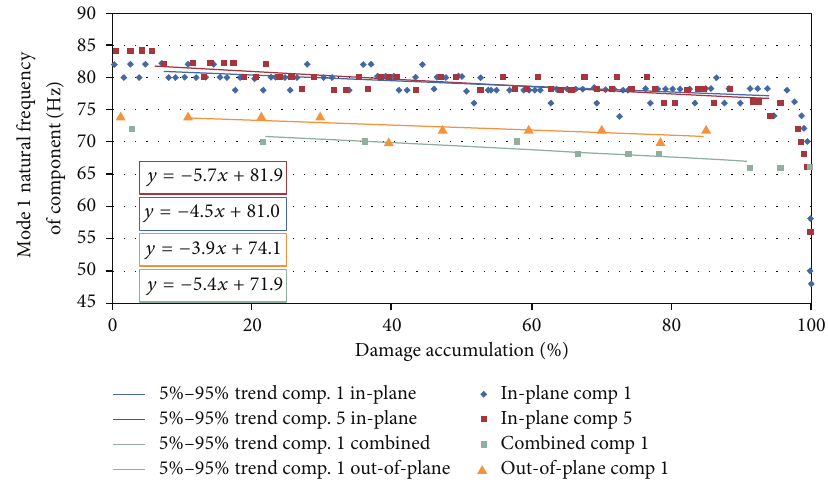
Figure 15: Change in the natural frequency as a function of damage accumulation [49].